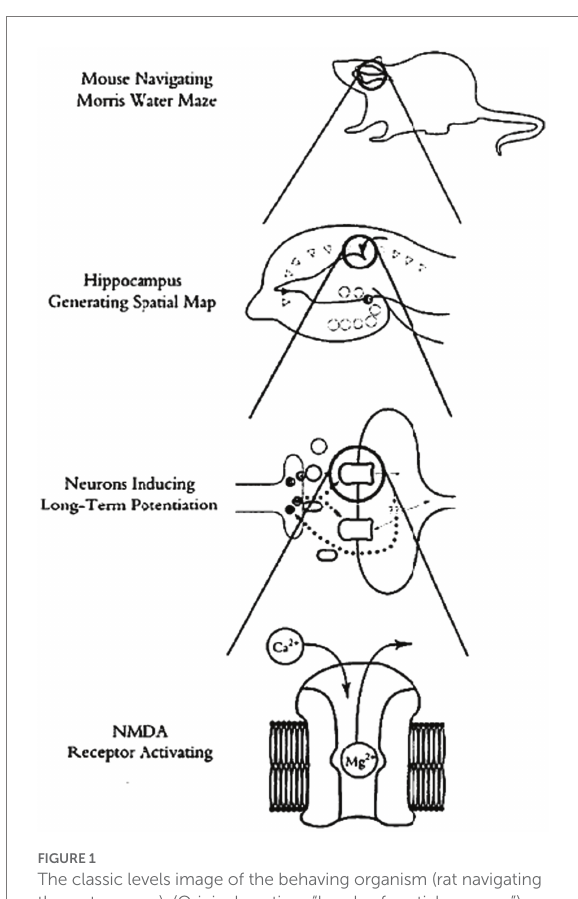
FIGURE 1 The classic levels image of the behaving organism (rat navigating the water maze). (Original caption: “Levels of spatial memory”) Reprinted with permission from Craver (2007), Figure 5.1,